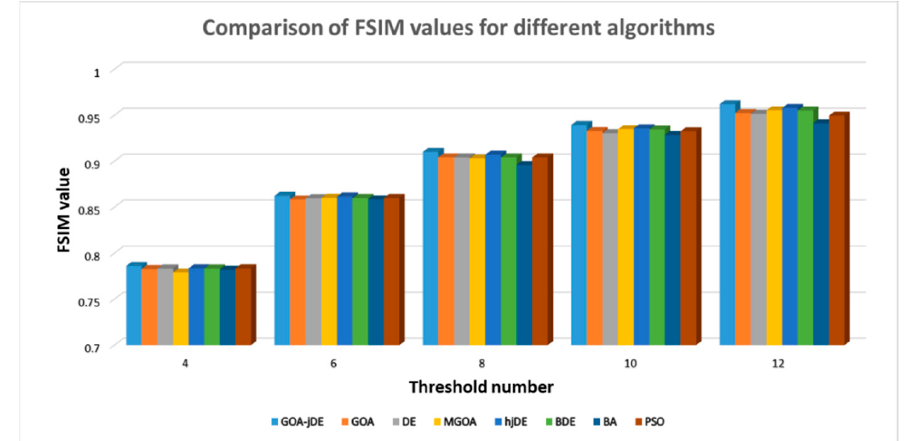
Figure 9. Comparison of SSIM values over all images using MCE method at 4, 6, 8, 10, and 12 levels.